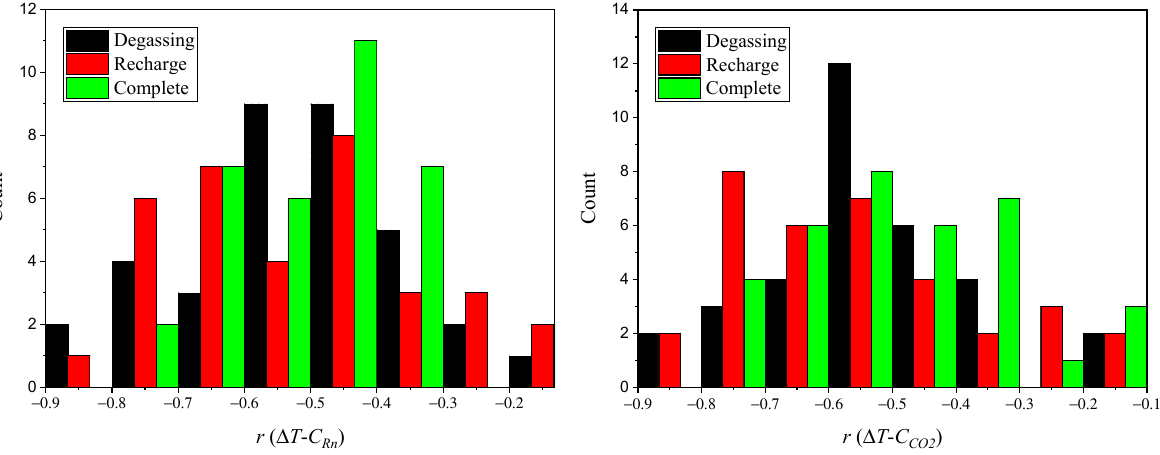
Figure 8. Distribution of maximum correlation coefficient r between the temperature gradient ∆ T and the concentration of gases, Rn and CO 2 , in degassing, recharging events or in complete periods.